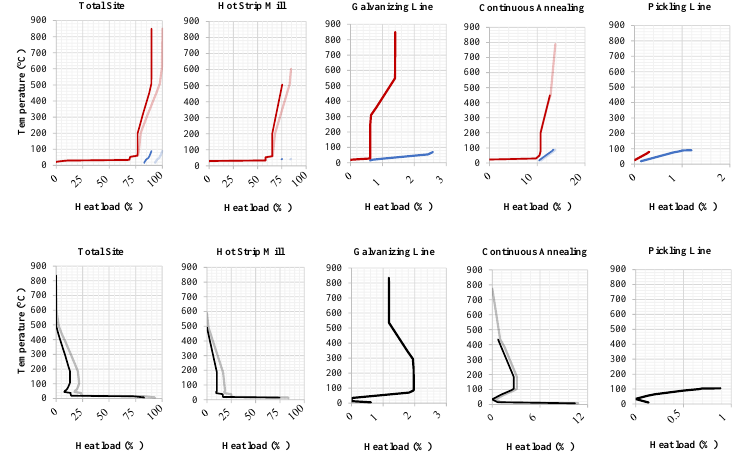
Figure 2. Composite Curves ( top ) and Grand Composite Curves ( bottom )—light colors indicate that streams with availability level 2 were considered.